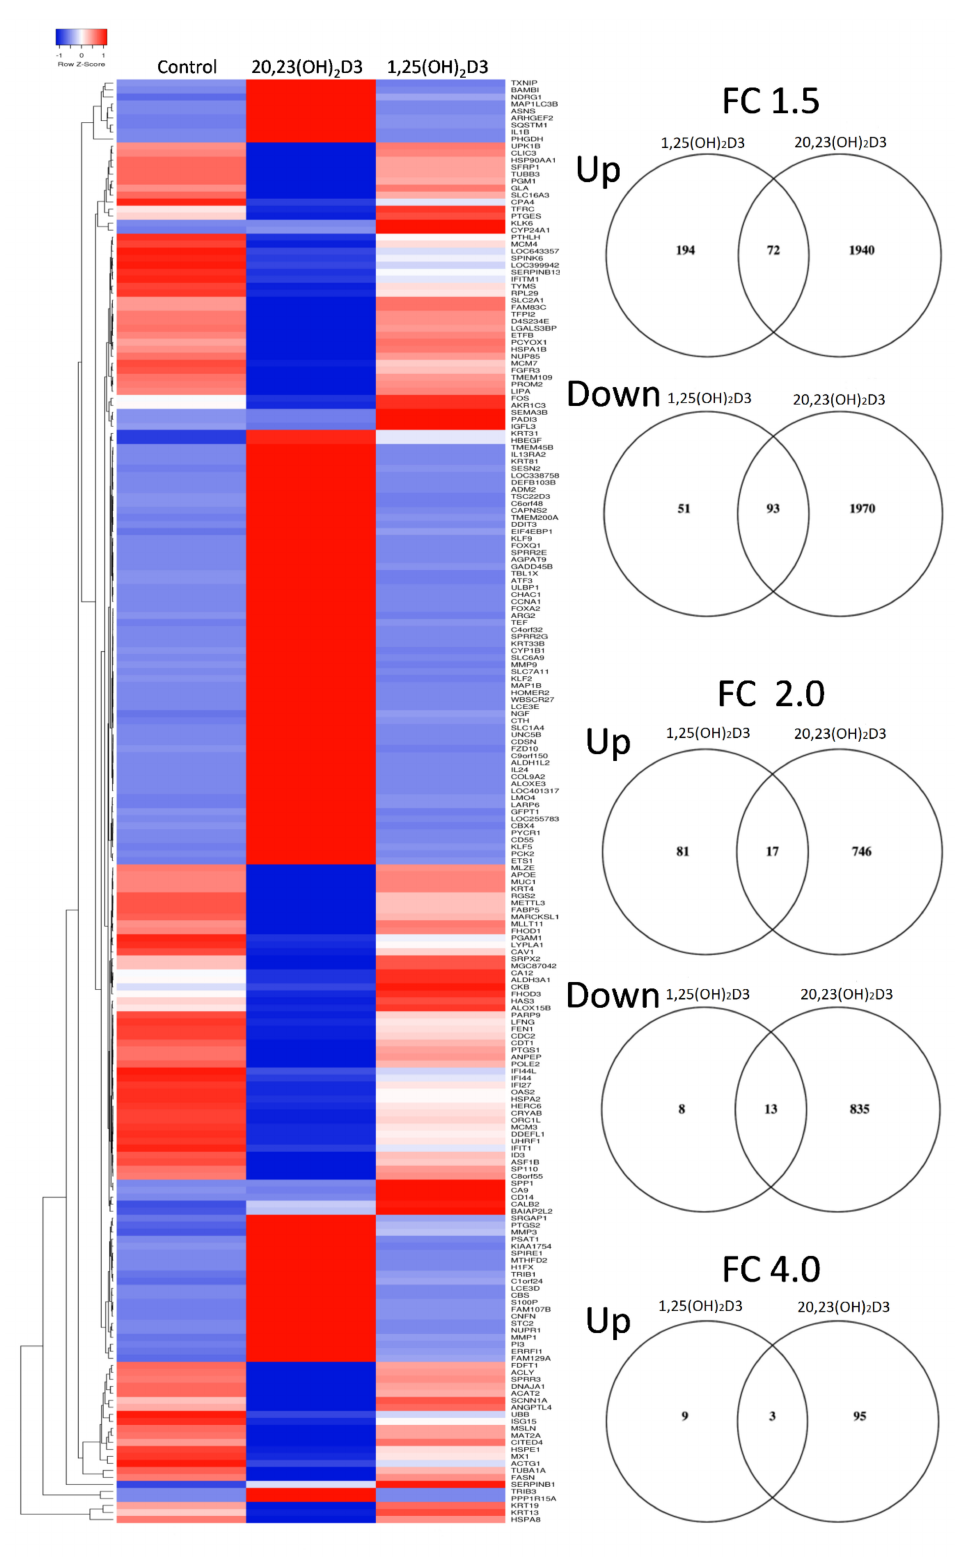
Figure 4. Heat map of gene expression pattern in human epidermal keratinocytes treated with 10 − 7 M of 1,25(OH) 2 D3 or 20,23(OH) 2 D3 for 24 h. On the right are the corresponding Venn diagrams for FC ≥ 4, 2 and